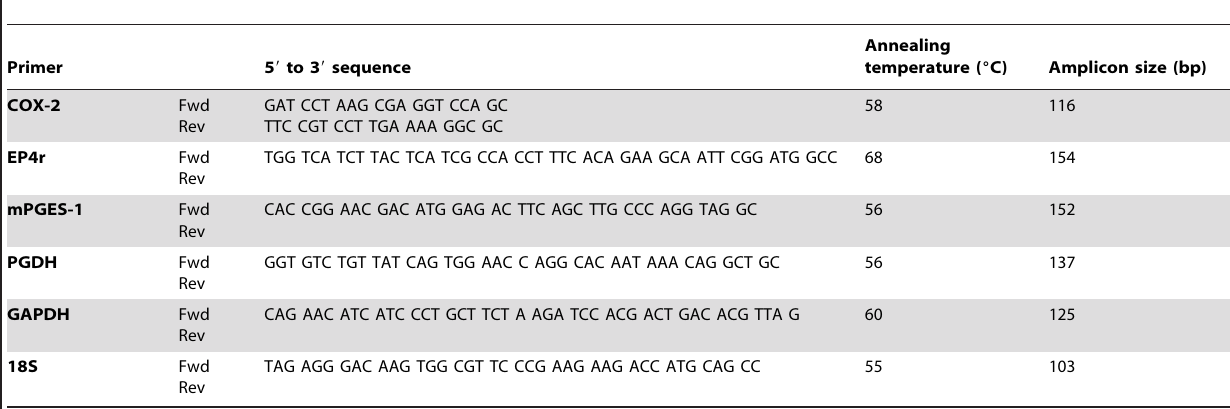
Table 1. Equine oligonucleotide sequences used for quantitative real-time PCR.